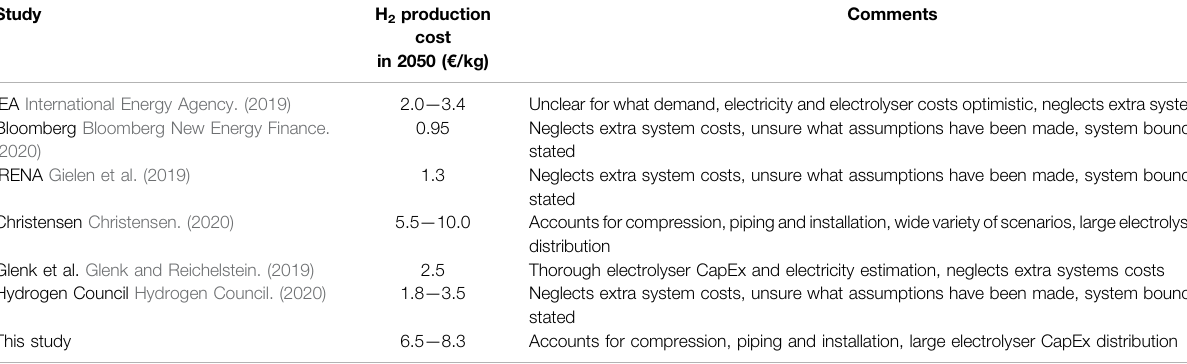
TABLE 4 | Comparison of the H 2 production cost in 2050 from various